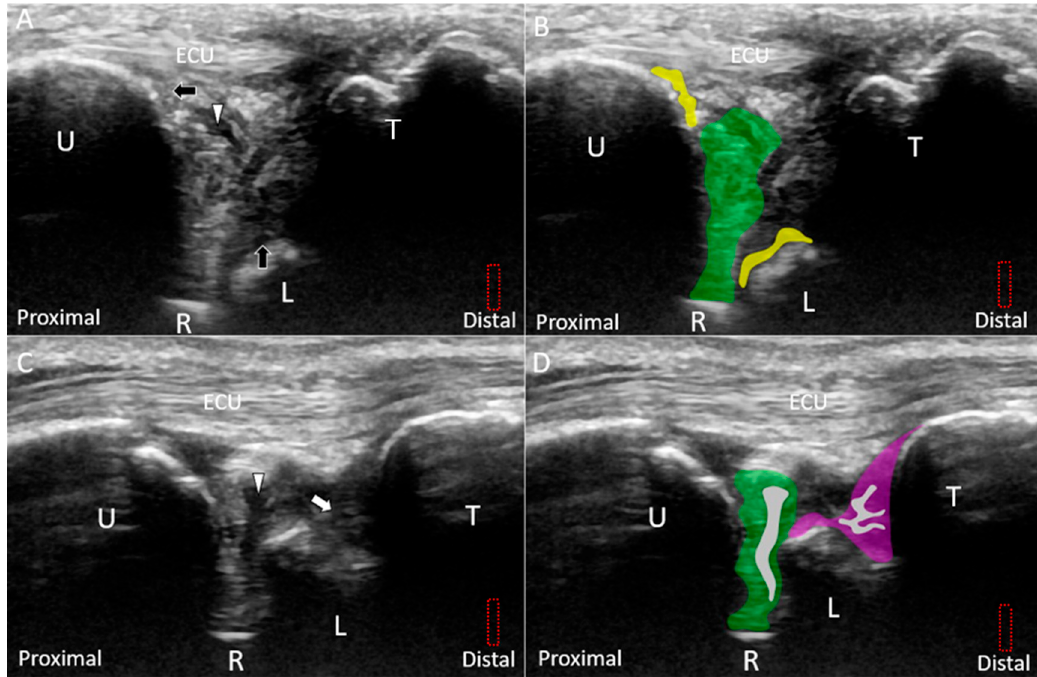
US images show rupture of the ECU tendon subsheath (black arrow and purple shade) with subluxation of the extensor carpi ulnaris (ECU) tendon (dark grey shade) using the short-axis approach. The di ff erent color dashed rectangles are in accordance with the transducer positions in Figure 3. US: ultrasound; U: ulna; L: lunate; T: triquetrum; ECU: extensor carpi ulnaris. J. Clin. Med. 2019 , 8 , x FOR PEER REVIEW